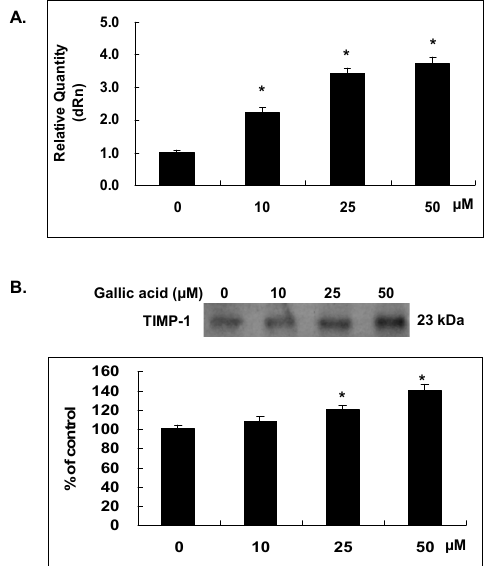
Figure 6. Gallic acid increased the TIMP-1 expression. NPC-BM1 cells were treated with gallic acid for 24 h and the expression levels of TIMP-1 mRNA ( A ) and protein in condition medium ( B ) were analyzed by qRT–PCR and Western blot respectively. The gallic acid dose-dependently increased TIMP-1 gene and protein expressions in NPC-BM1 cells. Delta Rn (dRn): The magnitude of the fluorescence signal generated during the PCR at each time point. Data were representative results from experiments repeated at least three times. * p < 0.05 versus vehicle control.